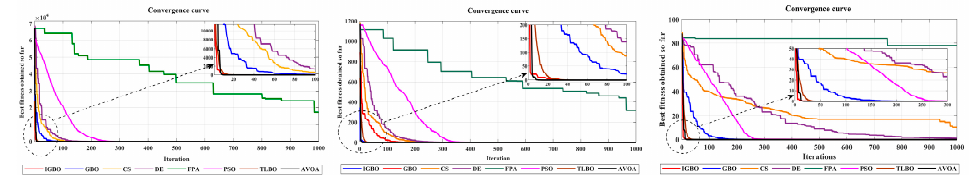
Figure 7. 3D design of the functions.